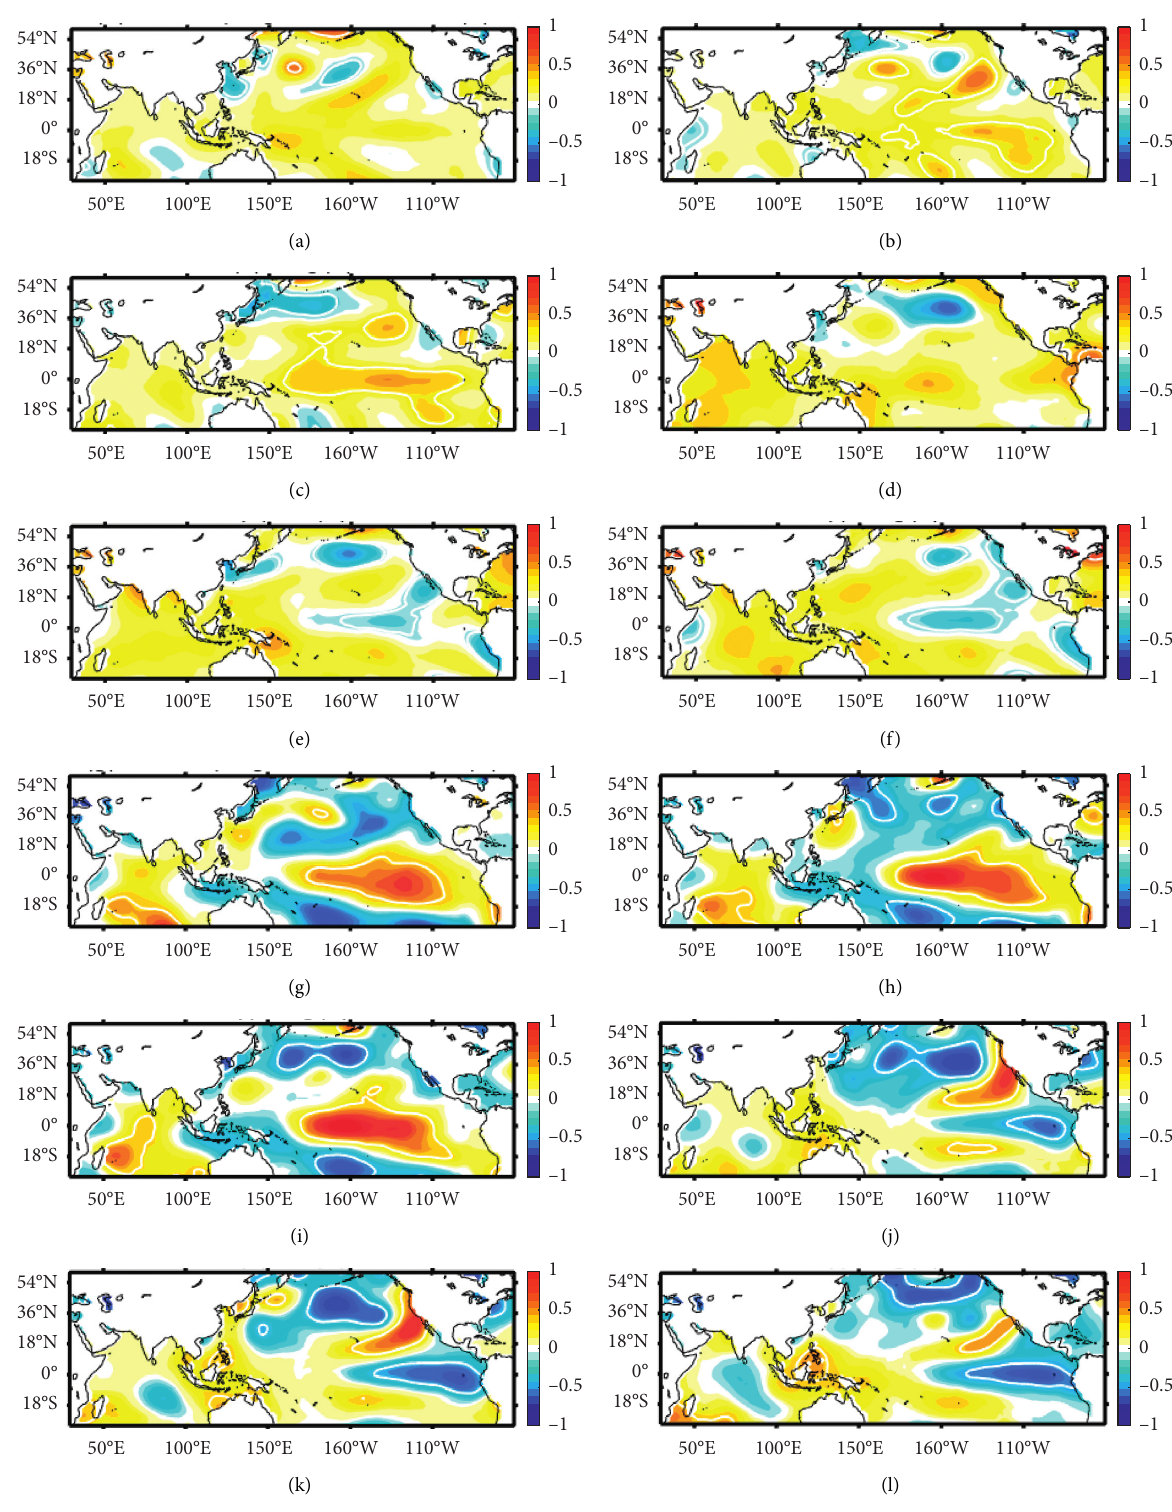
Figure 7: Composite SST anomalies (units: ° C) changes from June to August in the cool (a-f) and warm (g-l) PDO phases. White lines indicate the 95% and higher confidence levels using t -test. (a) Developing cool PDO Jun. (0). (b) Jul. (0). (c) Aug. (0). (d) Decaying cool PDO Jun. (1). (e) Jul. (1). (f) Aug. (1). (g) Developing warm PDO Jun. (0). (h) Jul. (0). (i) Aug. (0). (j) Decaying warm PDO Jun. (1). (k) Jul. (1). (l) Aug.